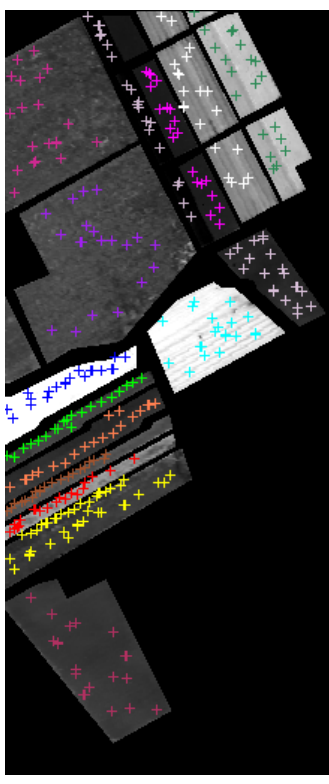
Figure 5: Training data collected over the